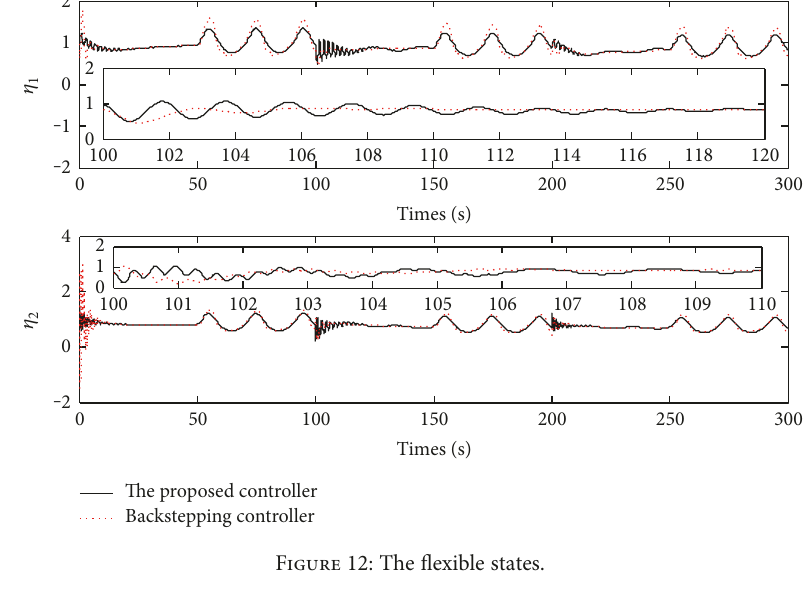
Figure 12: The fl exible states.